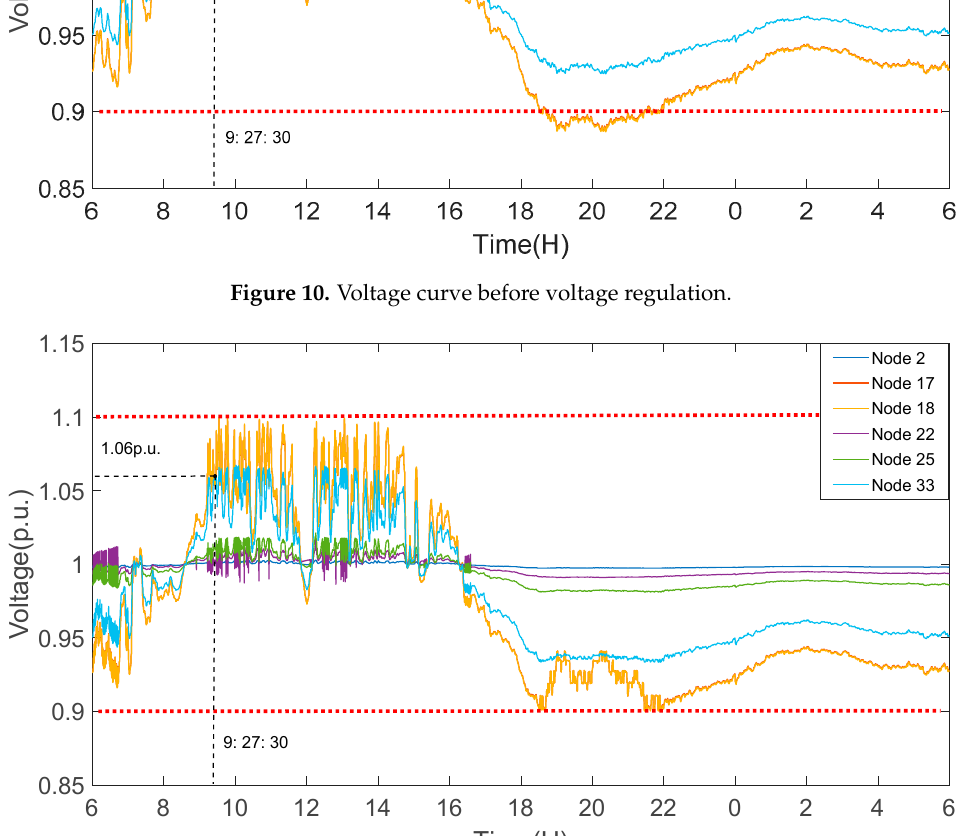
Figure 11. Voltage curve after voltage regulation.